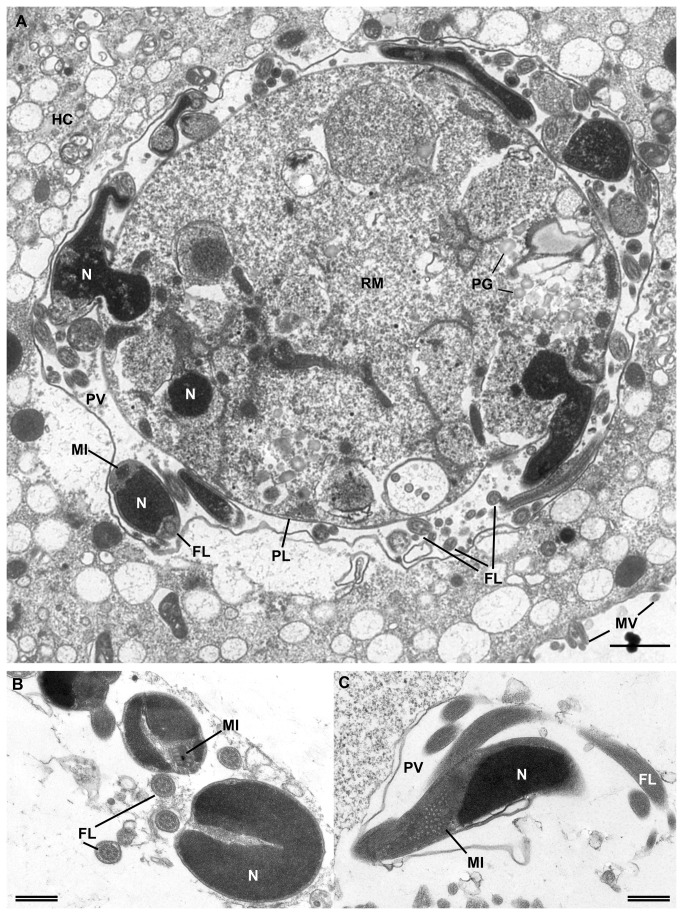
Electron micrographs of a microgamont and microgametes of

I

. suis
 in intestinal porcine epithelial cells (IPEC-J2).(A) section through a microgamont with budding microgametes on dpi 13; (B) transversal section through microgametes and flagella showing the 9x2 + 2 arrangement of microtubules within the flagella on dpi 12; (C) longitudinal section through the flagella and the body of a microgamete showing the typical large mitochondrion in the latter. dpi, days post infection; FL, flagella; HC, host cell; MI, mitochondrion; MV, host cell microvilli; N, nucleus; PG, polysaccharide granules; PL, plasmalemma; PV, parasitophorous vacuole; RM, residual cytoplasmatic mass; single bar = 1000 nm, double bar = 500 nm.